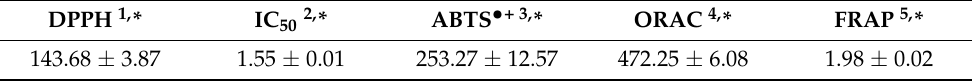
Table 2. In vitro antioxidant activity of Colombian berry ( V. meridionale Sw.) extract.